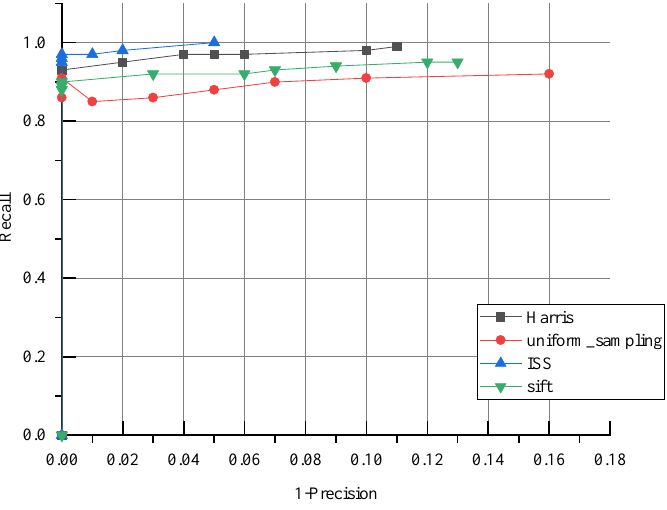
Figure 11. Combined performance of different keypoint detectors algorithms.